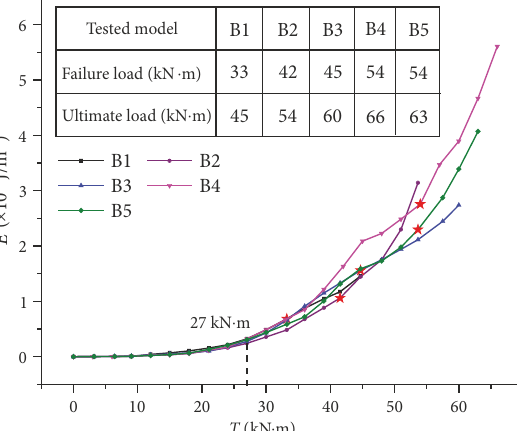
Figure 9. The strain distribution of stirrup for: a – B1; b – B2; c – B3; d –